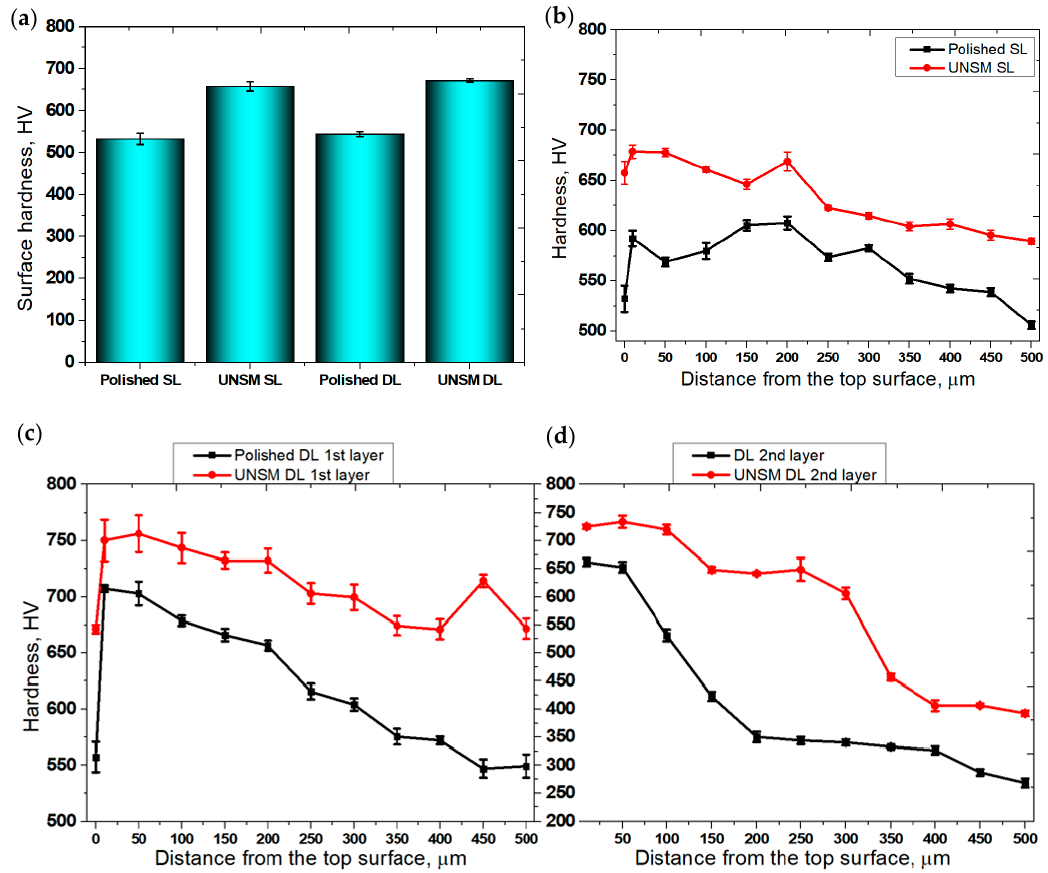
Figure 7. Comparison of surface hardness ( a ) and hardness with respect to depth of the polished and UNSM-treated single ( b ) and double ( c , d ) layers.